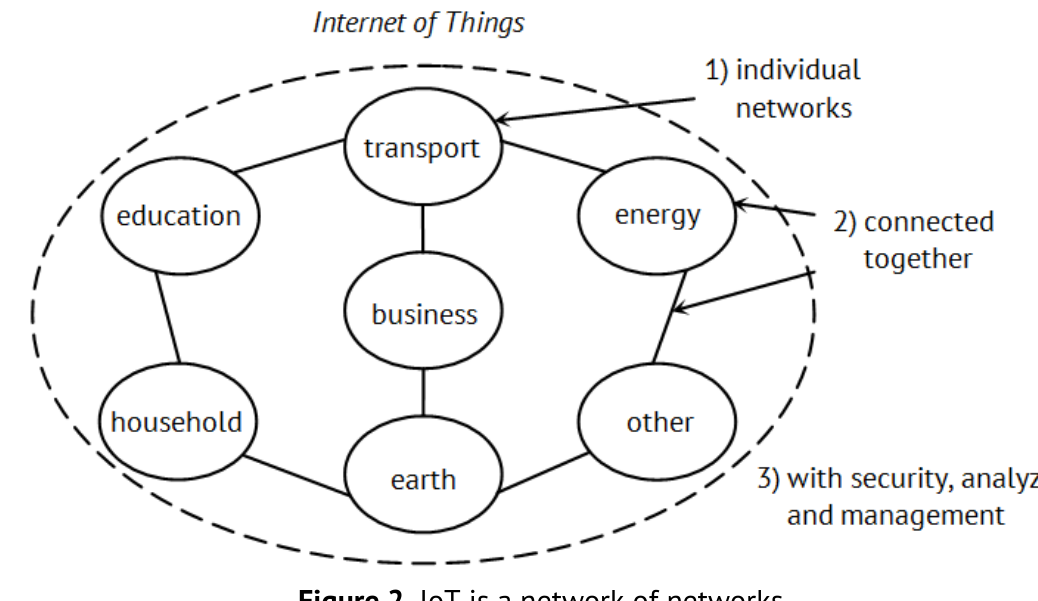
Figure 2. IoT is a network of